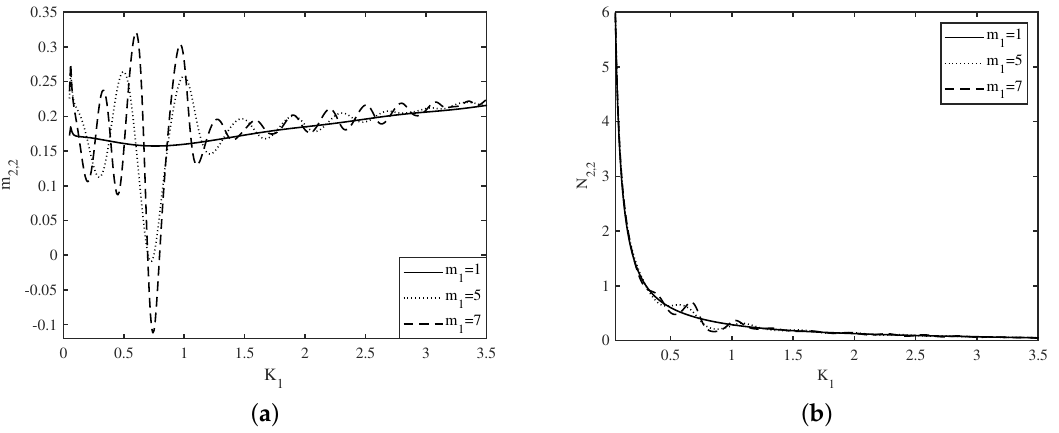
Figure 7. Variation of ( a ) m 2,2 and ( b ) N 2,2 vs K 1 for different m 1 . Figure 8 delineates (a) the added mass m 2,2 and (b) the damping coefficient N 2,2 versus the wavenumber K 1 as a function of depth ratio h 2 / h 1 . The overall pattern of m 2,2 and N